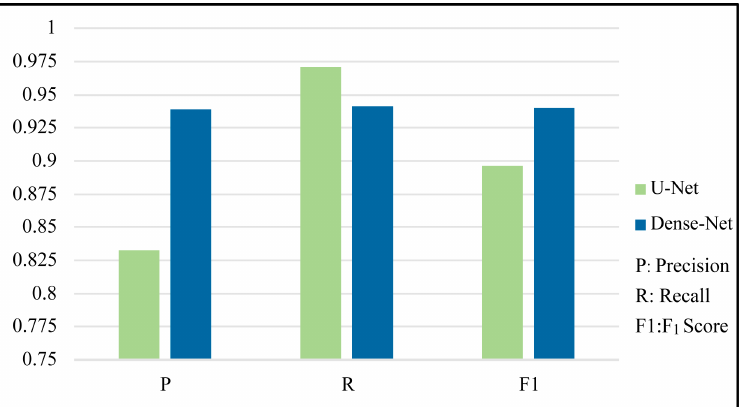
Figure 8. The results of road extraction from high-resolution remote sensing imagery using U-Net and DenseNet as feature extractors in the designed model.